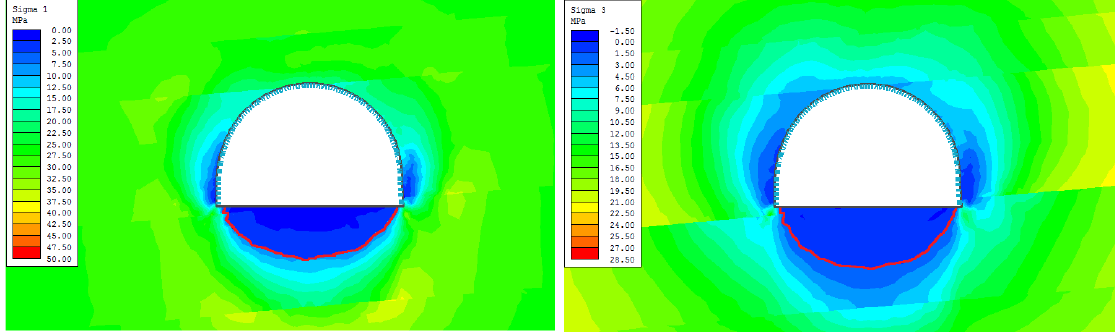
Figure 23. Extent of the failure zone beneath the waterlogged floor of roadway D-2 — stage 3.